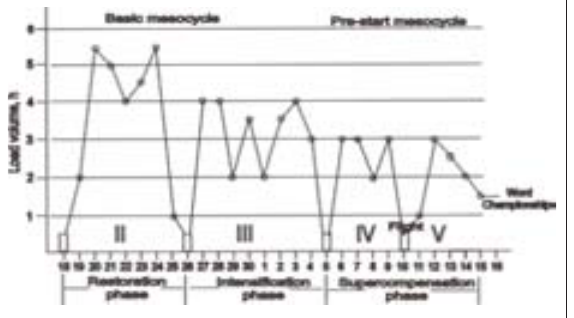
Fig. 1. Direct start preparation training of M. D., O. B., A. R. to the Team World Championships (Chile, 2001)